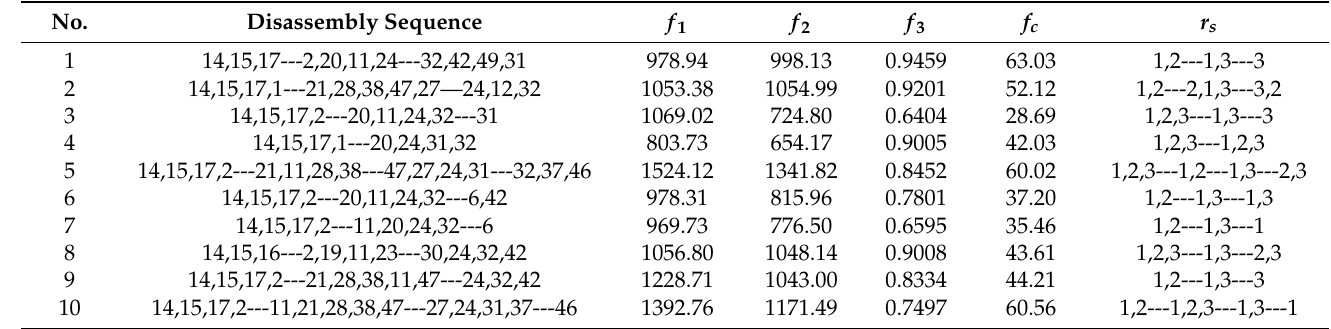
Table 3. The disassembly sequence and related data of instance 1 obtained by PIMBO algorithm program.